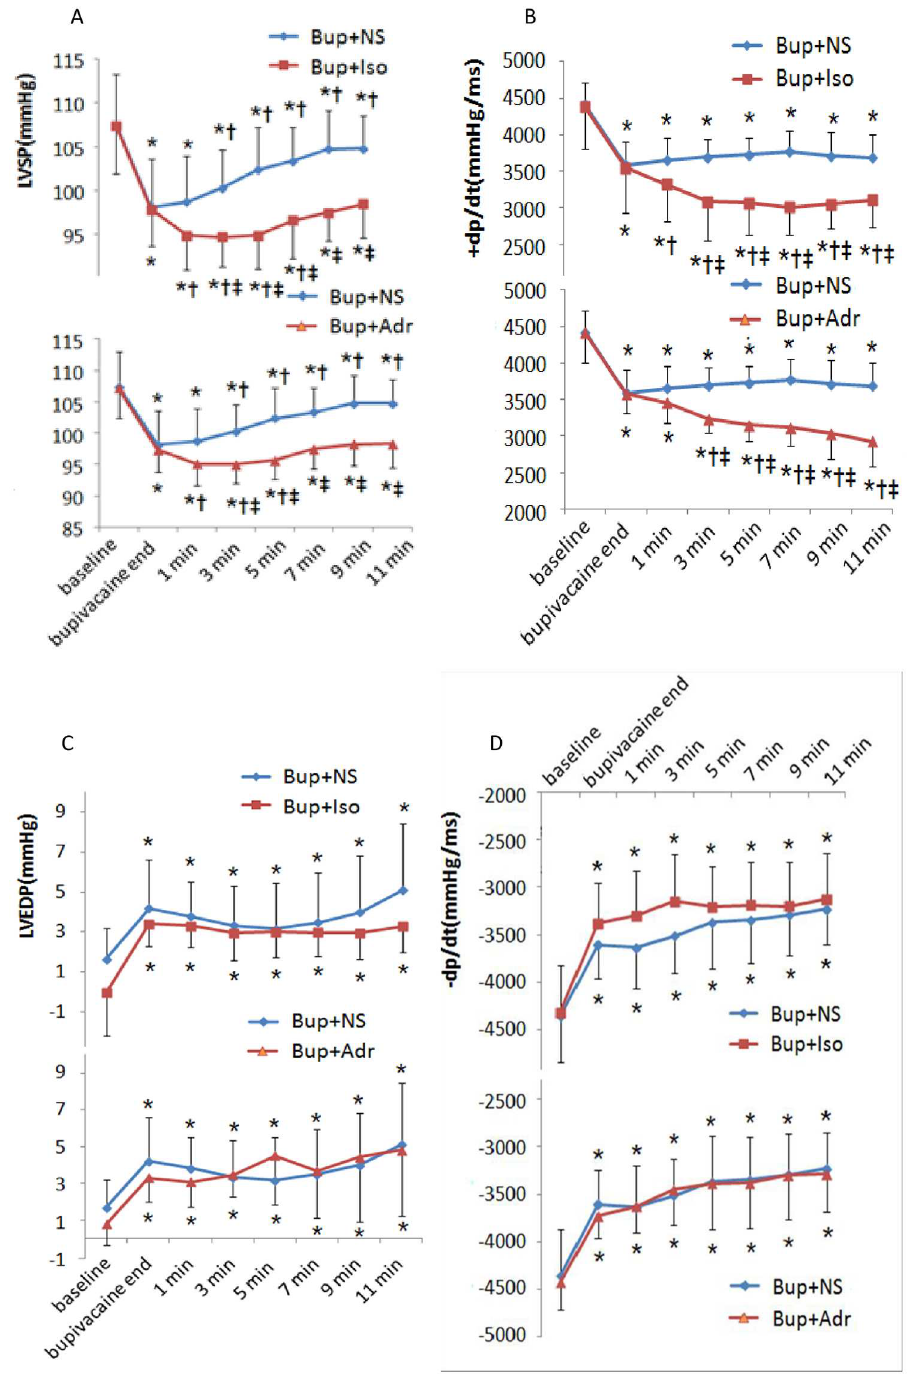
Fig 2. Inotropic effect of β -adrenergic agonists in bupivacaine-intoxicated rats. (A) and (B) Bupivacaine significantly reduced LVSP and +dp/ptmax, while isoprenalin and adrenalin induced a further reduction of LVSP and +dp/ptmax. (C) and (D) Bupivacaine significantly increased LVEDP and -dp/ptmax, while isoprenalin and adrenalin did not show a significant effect. (cid:3) P < 0.05, vs . baseline; † P < 0.05, vs . bupivacaine end; ‡ P < 0.05, vs . bupivacaine + NS